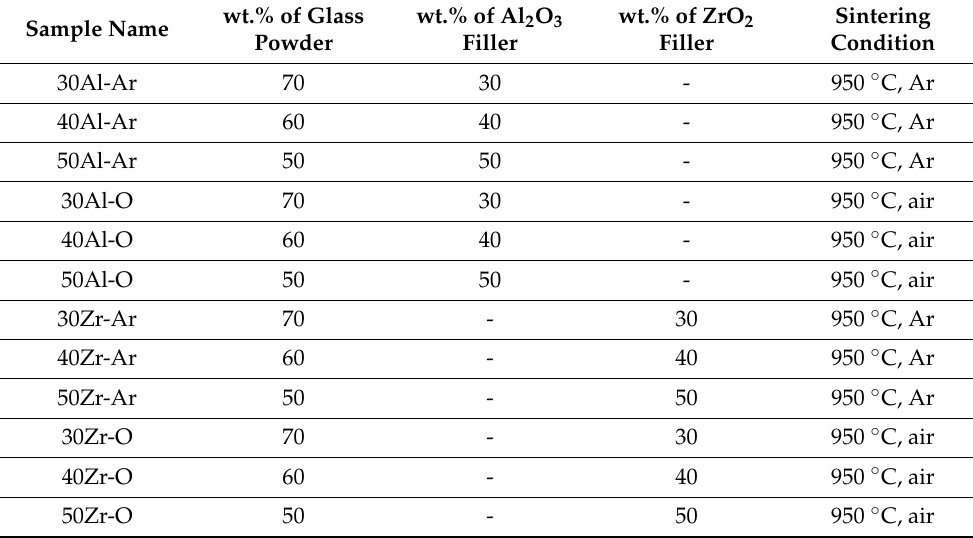
Table 1. Sample names and their production